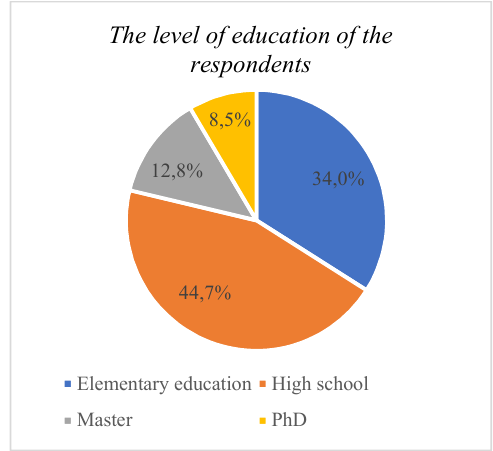
Figure 6. The level of education of the respondents